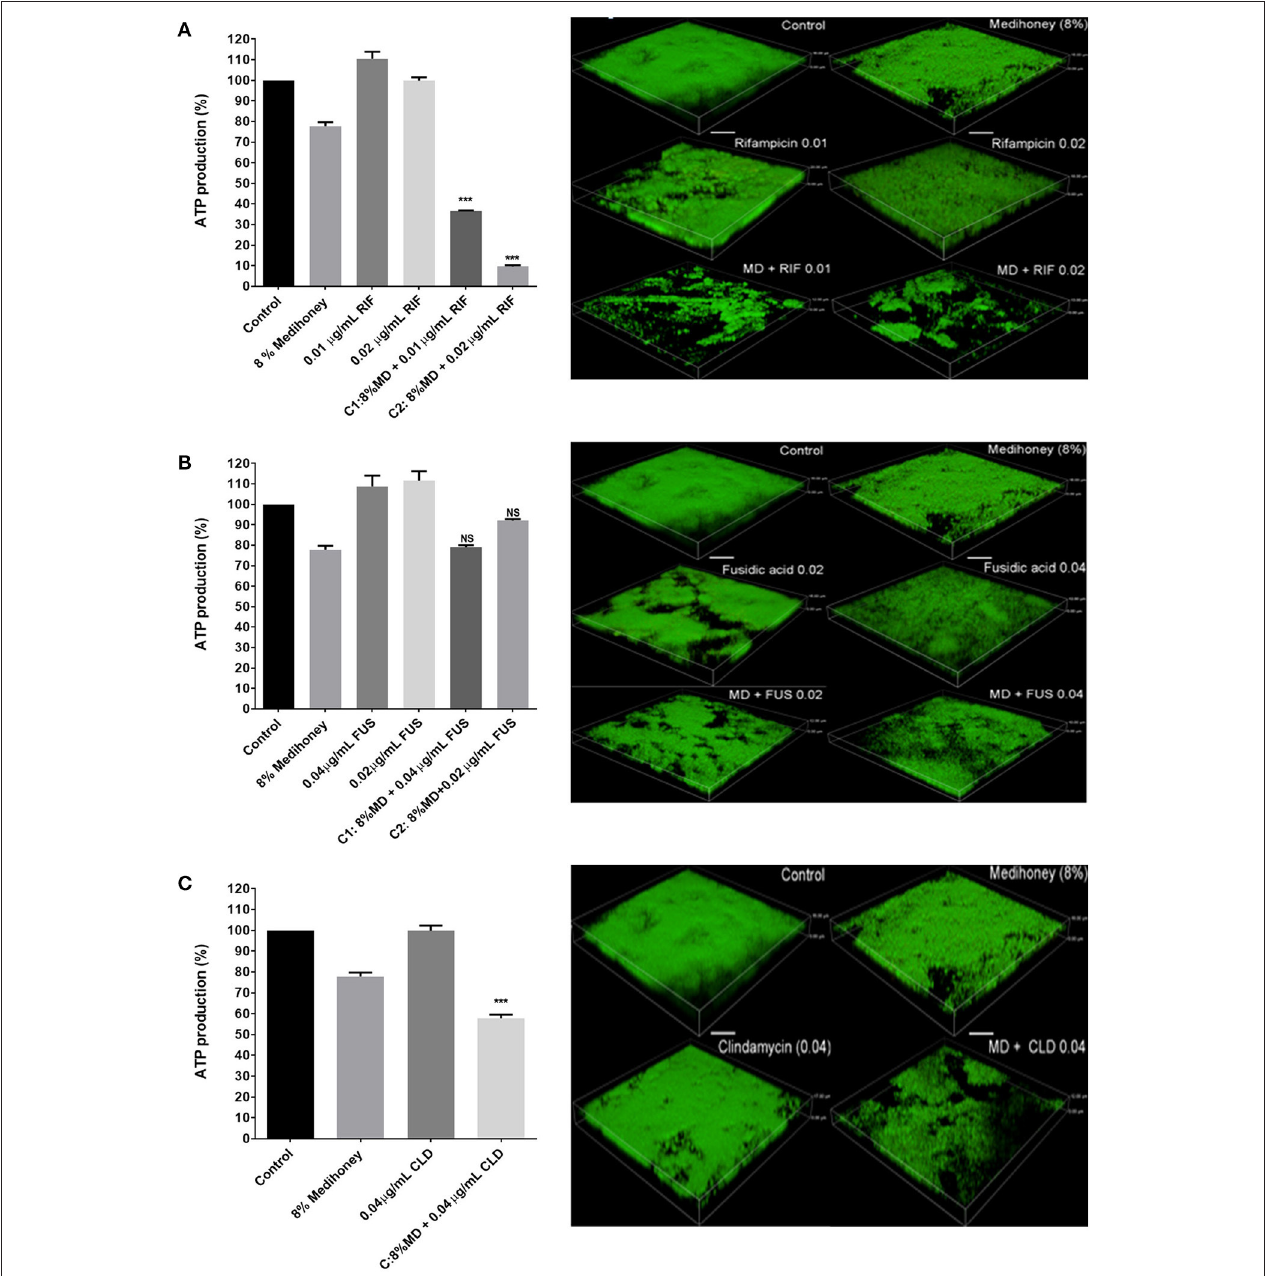
FIGURE 4 | Effects of Medihoney and antibiotic combinations on cell viability within biofilms and on biofilm structure. Medihoney (MD) was tested in combination with each of three antibiotics: (A) Rifampicin (RIF); (B) Fusidic Acid (FUS); (C) Clindamycin (CLD). Left panels: viable cells remaining within the established biofilm following treatment with Medihoney-antibiotic combinations were evaluated using the BacTiter-Glo assay, which measures the production of ATP. The percentage of viable cells was calculated relative to the untreated control, which was set at 100%. Statistical significance ( p < 0.05) was assessed by one-way ANOVA with a Tukey post-hoc test. Medihoney-fusidic acid was the only tested combination found to be not significant (NS). Right panel: 3-D images produced by confocal laser scanning microscopy of established biofilm after combination treatment. Biofilms were stained with SYTO TM 9 (green = viable cells). Both the thickness and structure of